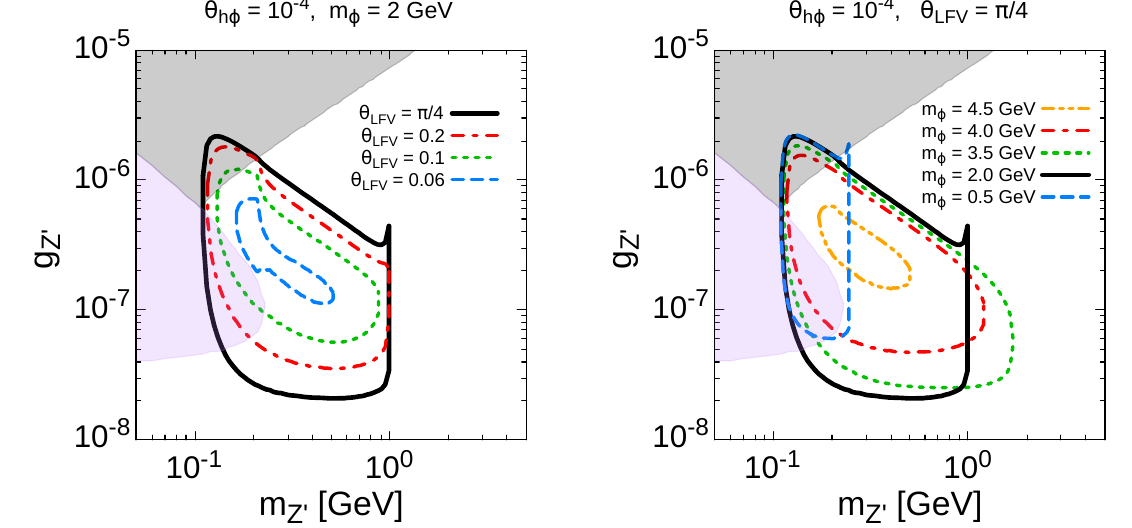
Figure 3 . The contour plots of 95 % C.L. sensitivity regions for the vector-type interaction in the m Z 0 − g Z 0 plane. The gray and the purple shaded area are excluded by µ → eee and E137, respectively, for θ LFV = π/ 4 .